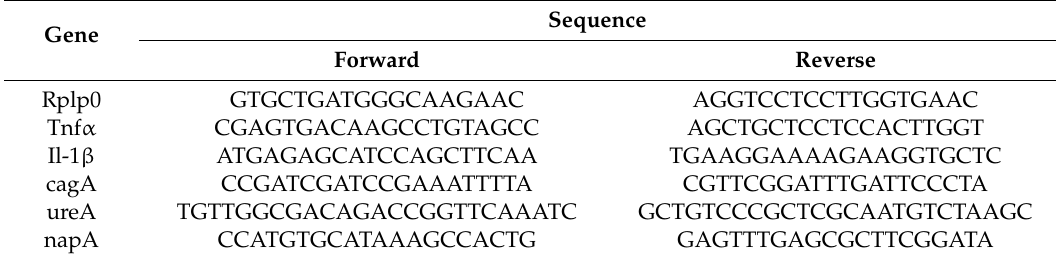
Table 1. Primers used in this